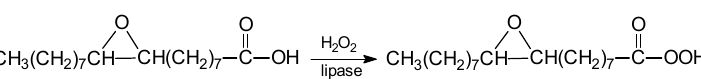
Scheme 2. Formation of epoxidized peroxy fatty acids.